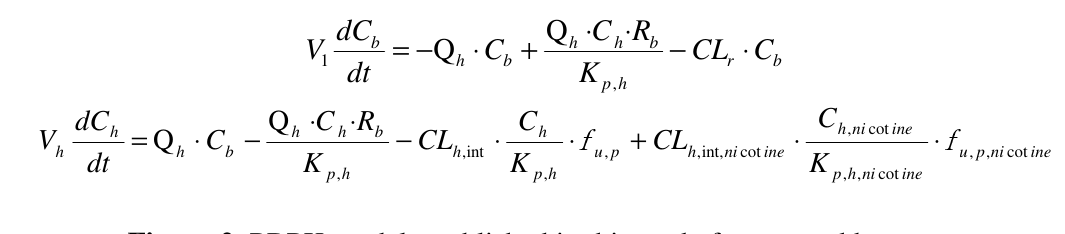
Figure 2. PBPK model established in this study for rats and humans.